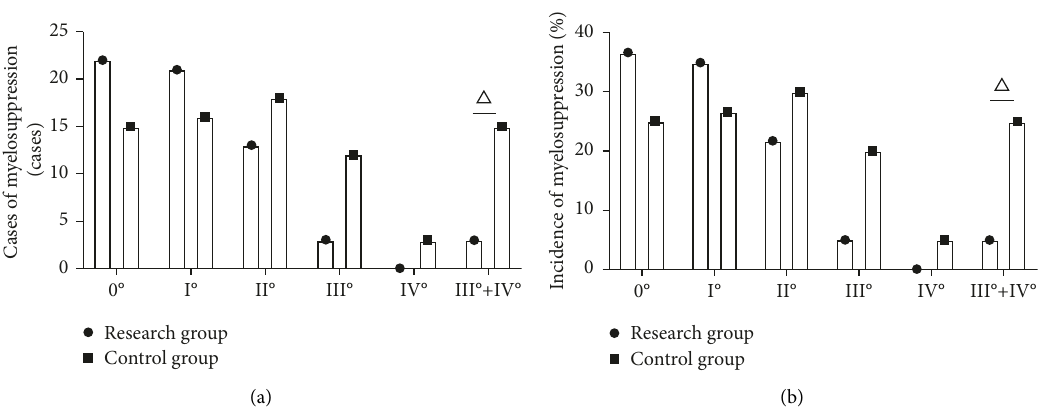
Figure 6: Comparison of the occurrence of myelosuppression for both groups. Note: Δ is the difference between the two groups, P < 0 . 05. (a) Cases of myelosuppression (cases) and (b) incidence of myelosuppression